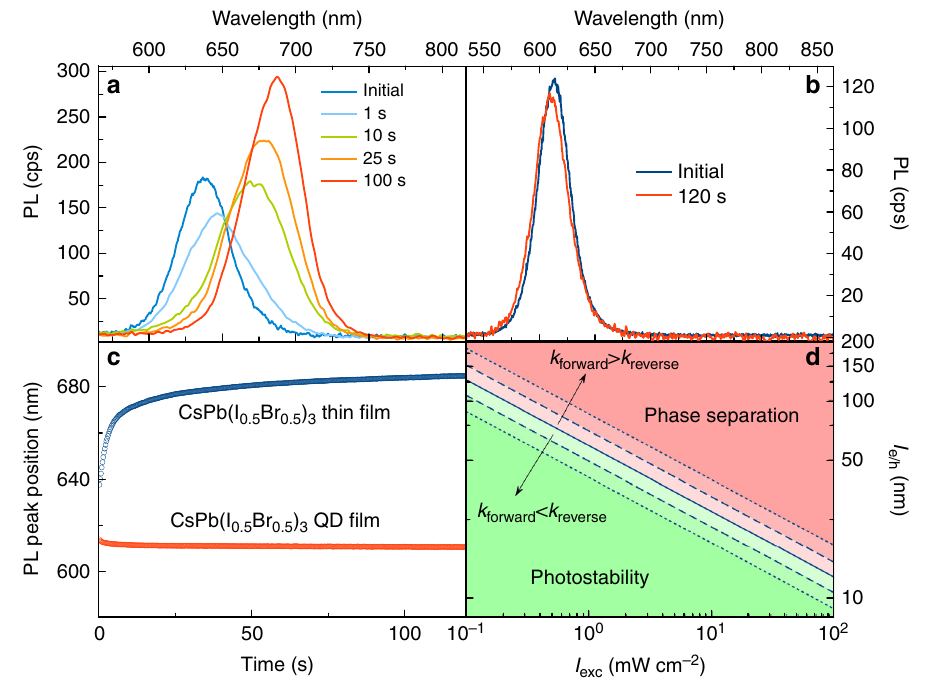
Fig. 4 Halide phase segregation versus photostability. Time evolution of CsPb(I 0.5 Br 0.5 ) 3 a thin fi lm and b nanocrystal-based fi lm emission spectra (PL, photoluminescence) under 405 nm continuous wave (CW) excitation ( I exc = 60 mWcm − 2 ). c CsPb(I 0.5 Br 0.5 ) 3 thin fi lm and nanocrystal-based fi lm emission peak position during illumination. d Photostability phase diagram of MAPb(I 1 − x Br x ) 3 (MA = CH 3 NH 3 + ) obtained from Eq. 0.038 s − 1 (Fig. 1b) and k forward,em = 0.7 s − 1 (Fig. 1a), we estimate a